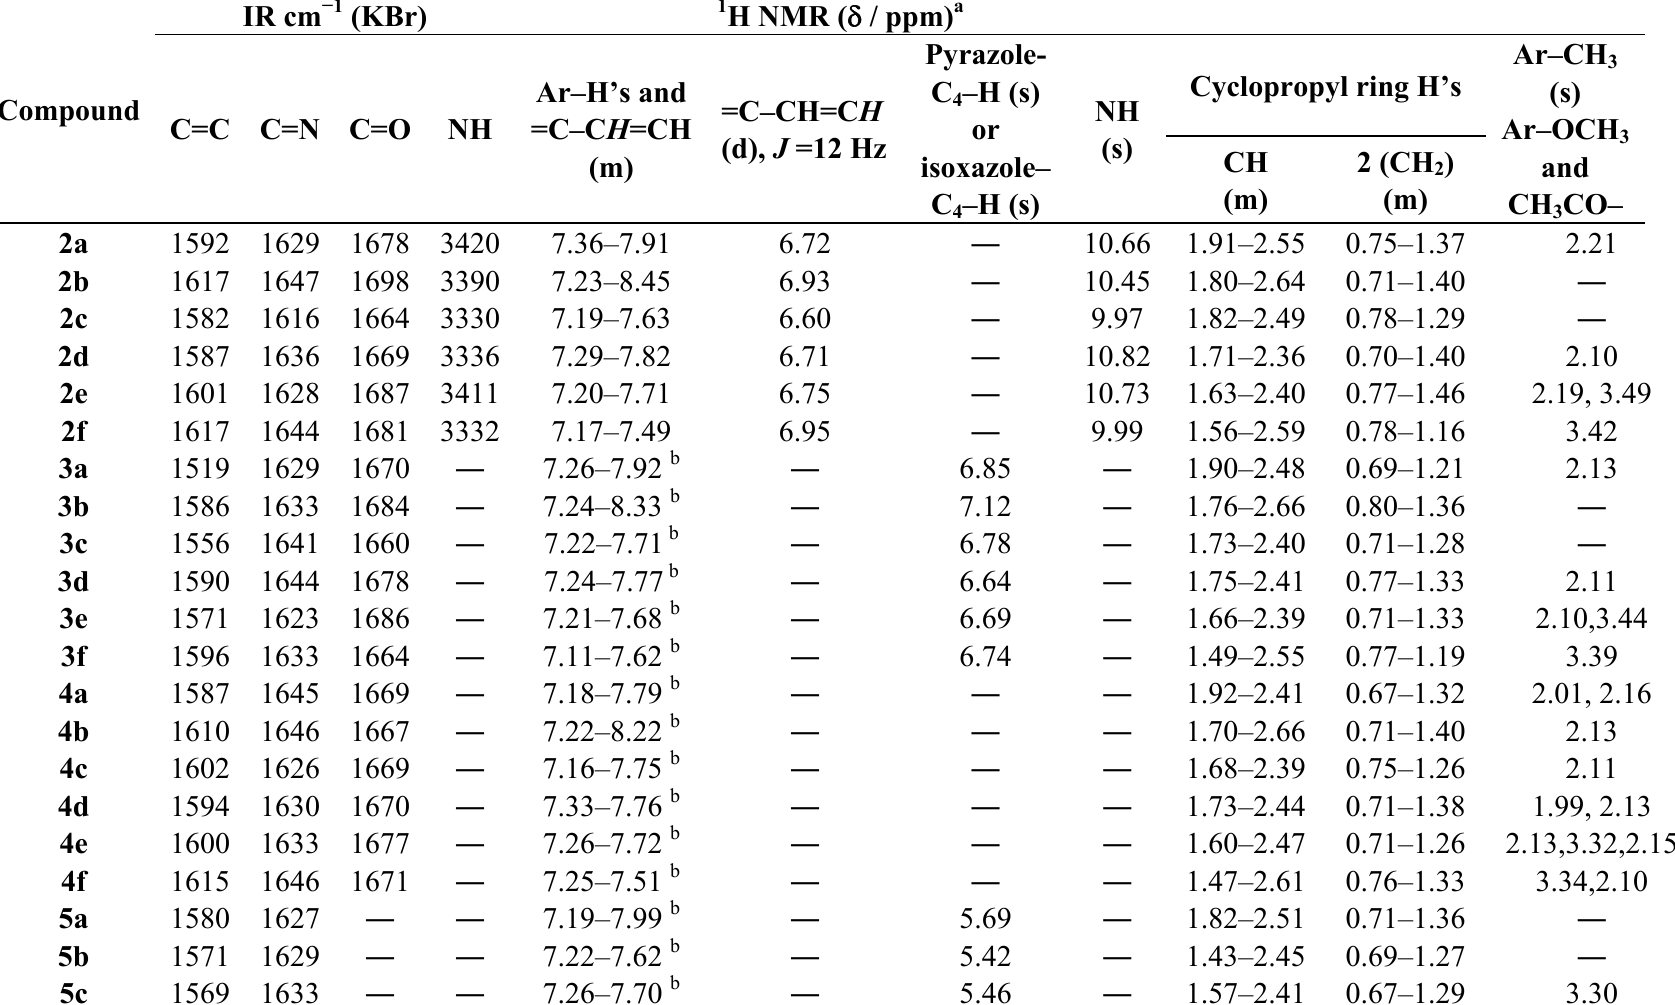
Table 2. IR and 1 H-NMR spectral data of compounds 2a–f , 3a–f , 4a–f and 5a–c